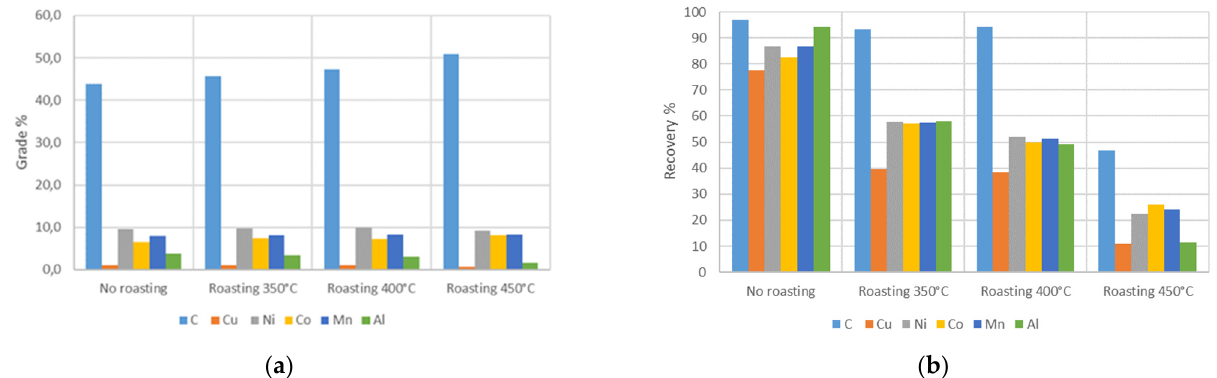
Figure 5. Effects of roasting on grade ( a ) and recovery ( b ) of main components in the flotation concentrate for − 0.25 mm fraction.